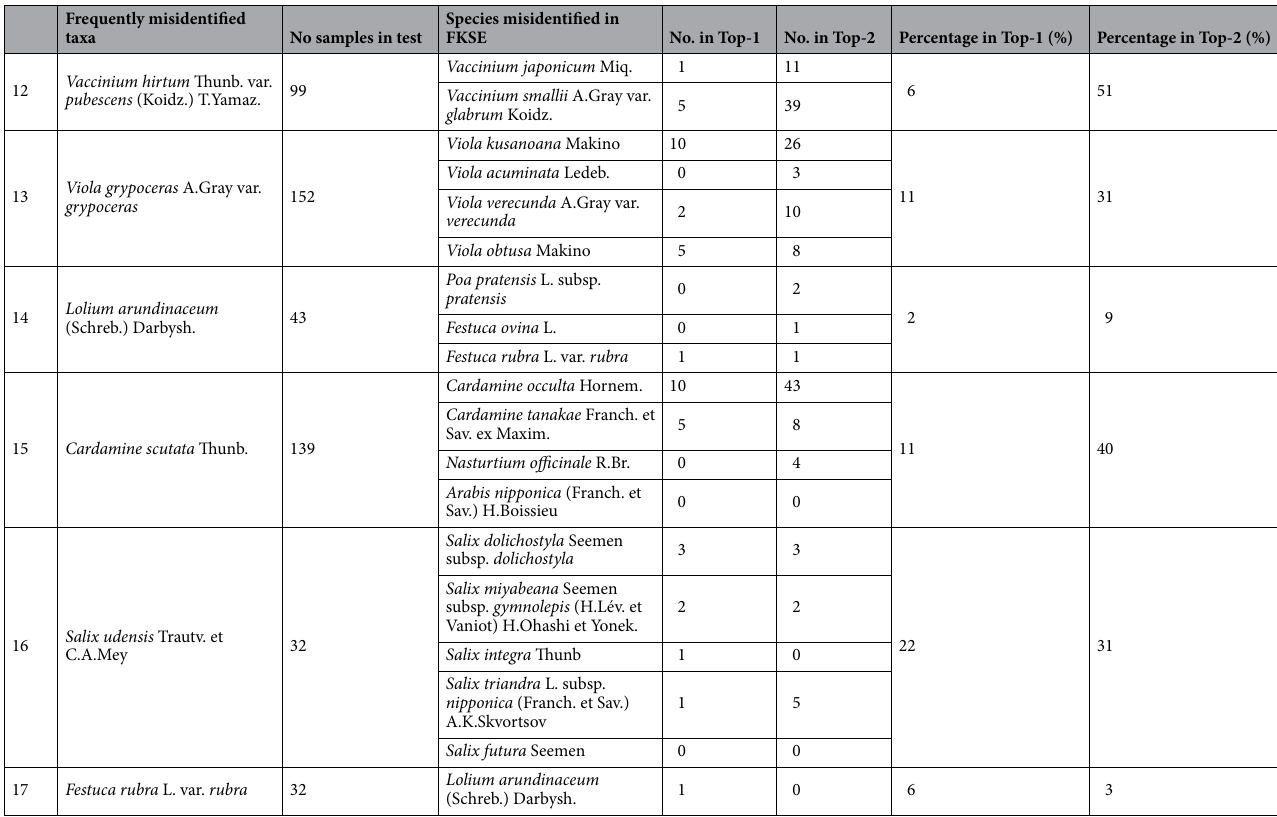
Table 2. List of 17 taxa that are frequently misidentified in the records of identification history of the specimens in the Herbarium of University Archives and Collections, Fukushima University